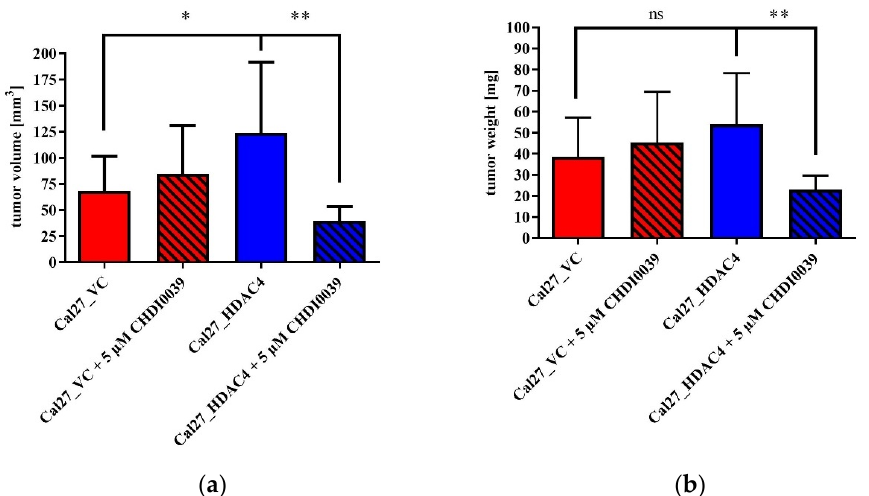
Figure 3. Effects of HDAC4 overexpression and treatment with 5 µ M CHDI0039 on tumor volume ( a ) and weight ( b ) in the chorioallantoic membrane (CAM) model. Tumors were seeded on the CAM and grown for 7 days. Treatment with CHDI0039 or buffer control was conducted at day 2 and day 4 after seeding. Values represent means ± SD of at least three independent experiments. Significance was calculated by t -test (ns: not significant; * p ≤ 0.05; ** p ≤